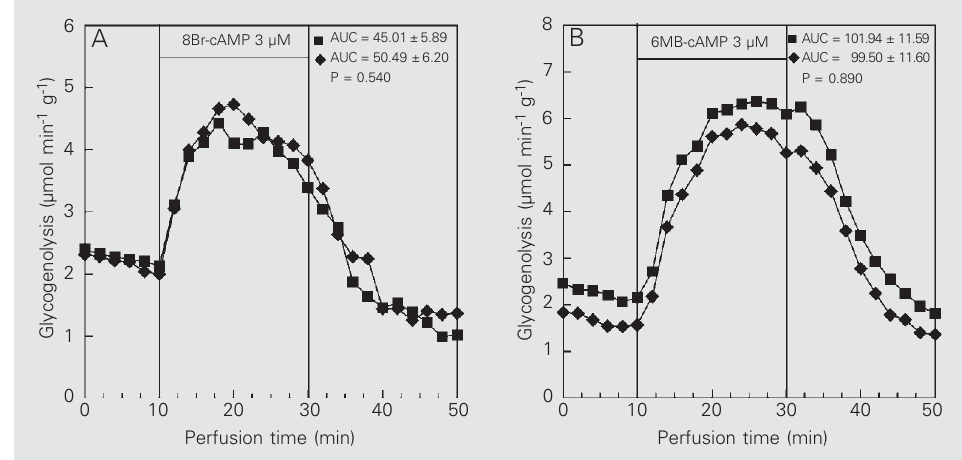
Figure 4. Effect of 8-bromo- adenosine-3'-5'-cyclic mono- phosphate (8Br-cAMP) (panel A) or N 6 -monobutyryladenosine-3'- 5'-cyclic monophosphate (6MB- cAMP) (panel B) on glycogenoly- sis in the presence (lozenges) and absence (squares) of insulin (500 µIU/ml). The data are re- ported as the mean of 3-5 indi- vidual liver perfusion experi- ments. The area under the curve (AUC) data (µmol/g liver fresh weight ± SEM) are (cid:0) presented in the figure. The statistical test used was the unpaired Student t